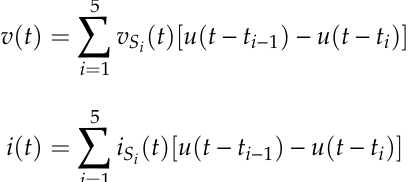
Table 4. Values for synthetic signals.